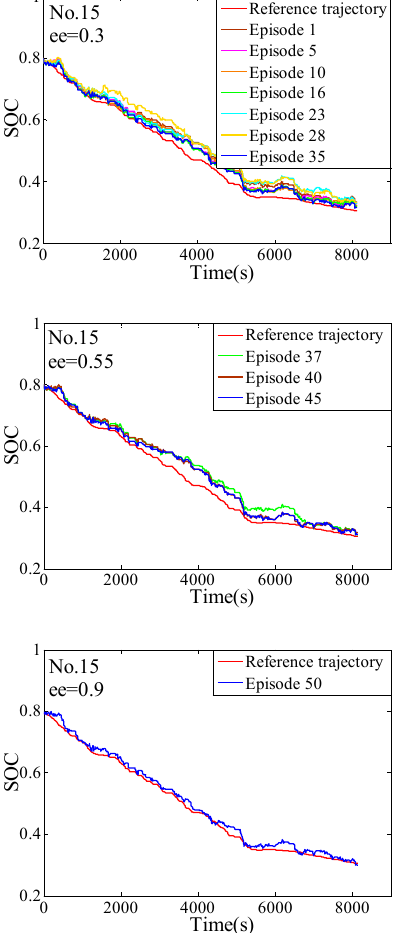
Figure 14. The training process of combined driving cycle 15.